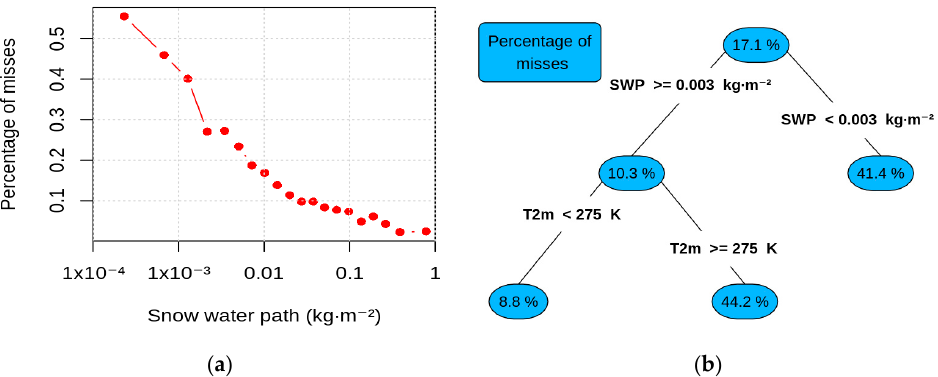
Figure 3. ( a ) Percentage of missed snowfall occurrence as a function of SWP; and ( b ) decision tree, with the percentage of missed snowfall occurrences indicated in boxes, and partitioning variables and thresholds indicated on